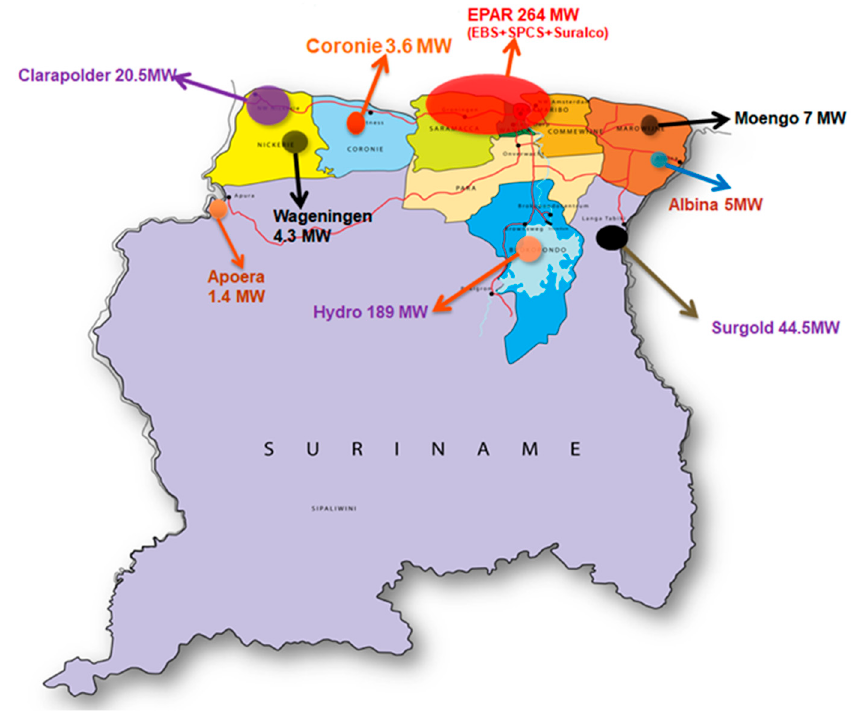
Figure 3. Electric power plants in Suriname. The source of this map is N.V EBS (2016) [7].